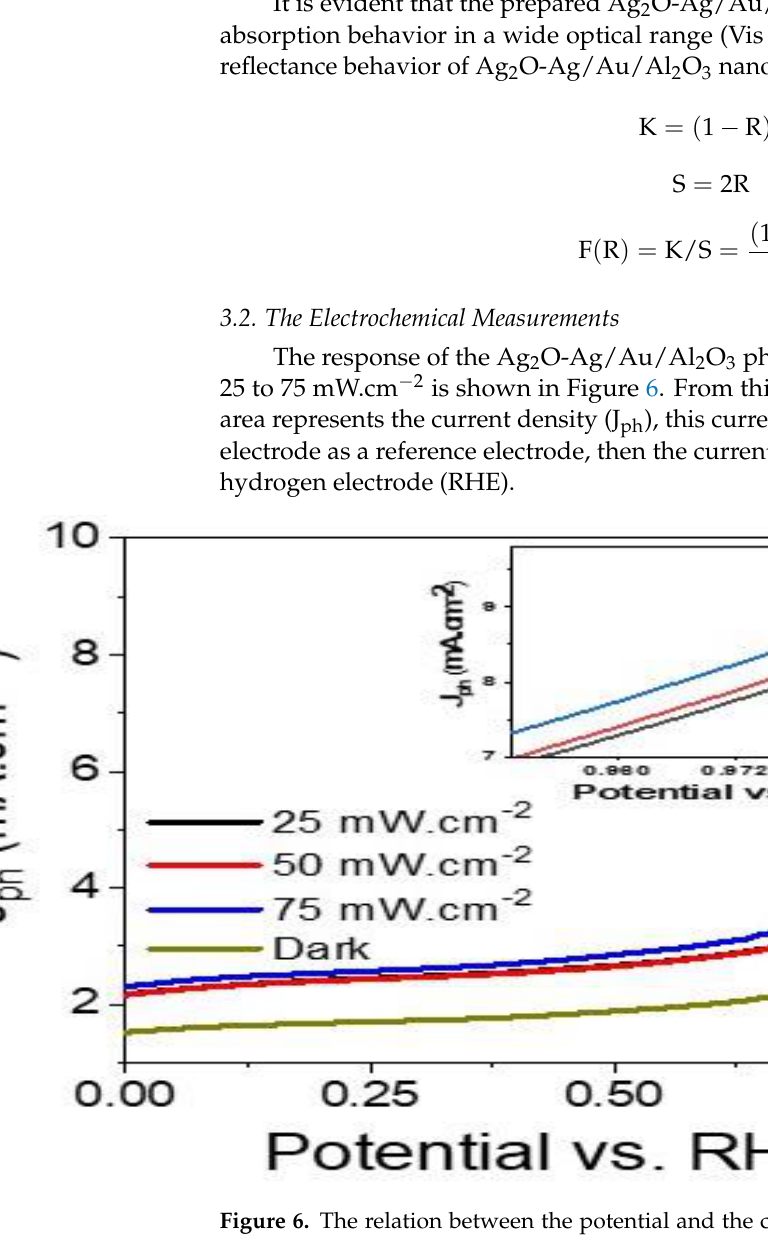
Figure 6. The relation between the potential and the current density (insert figure represents the magnification of the current density at 0.94 to 1.0 V) for the Ag 2 O-Ag/Au/Al 2 O 3